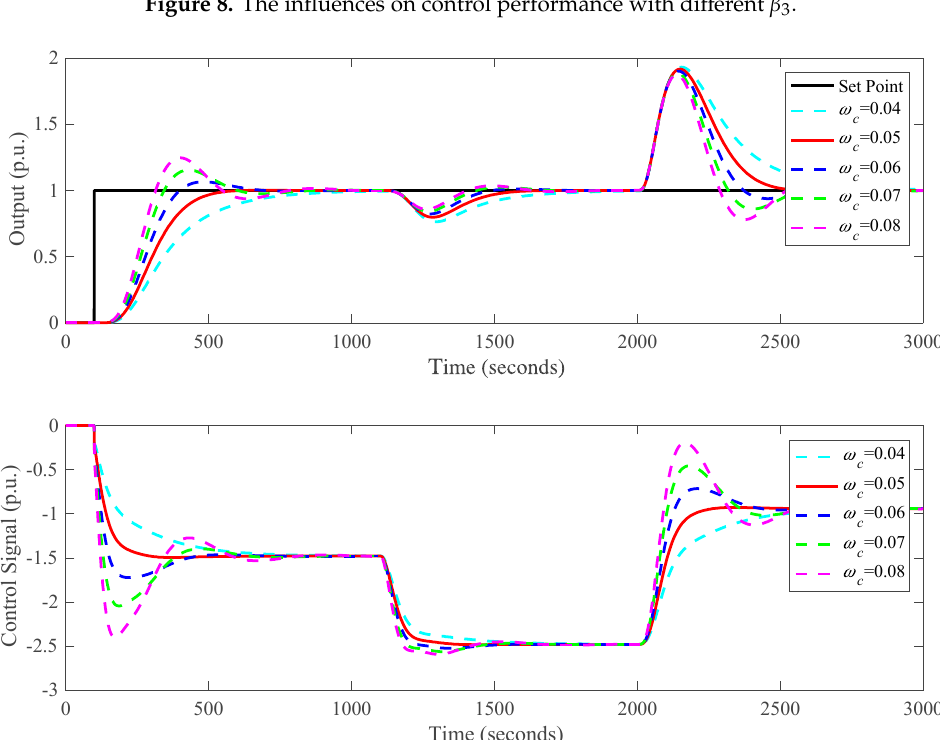
Figure 9. The influences on control performance with different ω c .